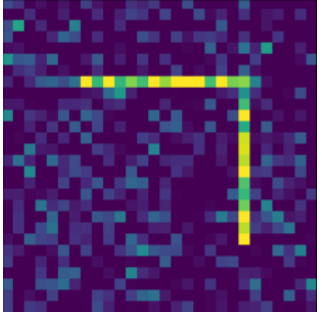
Figure 21. Rotated object, with level 2 noise.